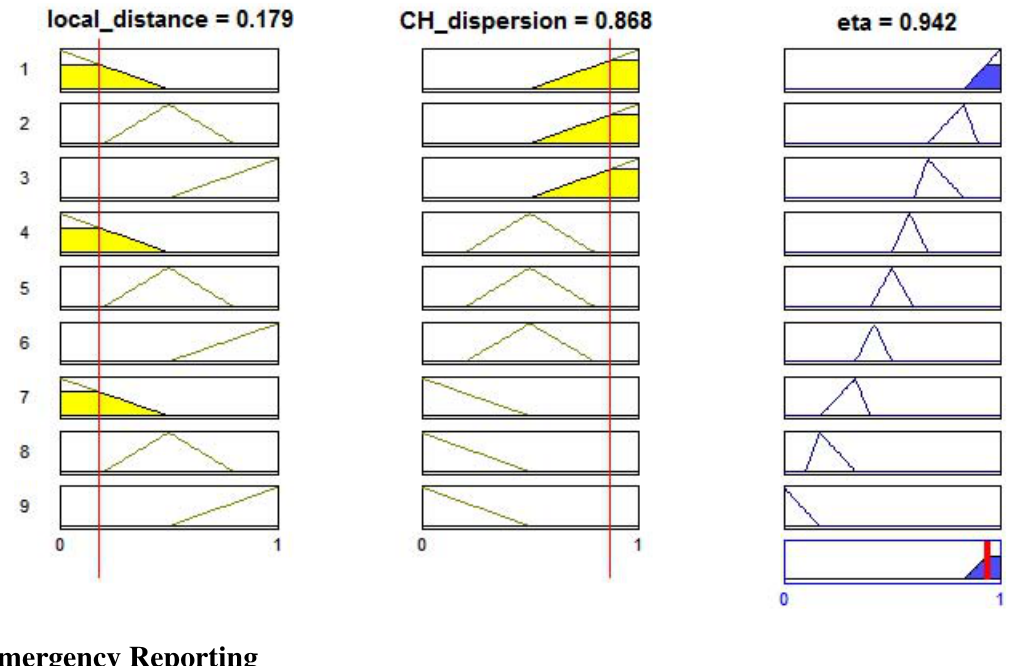
Figure 1. The eta defuzzification after computing the input variables, local distance and CH dispersion , over nine fuzzy